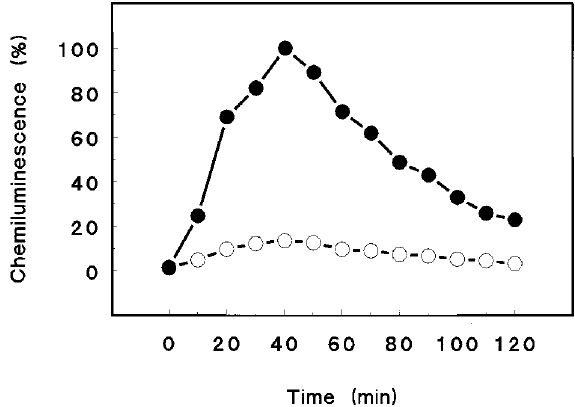
FIG. 2. Zymosan-induced chemiluminescence generation by isolated guinea-pig two ring tracheal preparations with ( d ) or without epithelial layers ( s